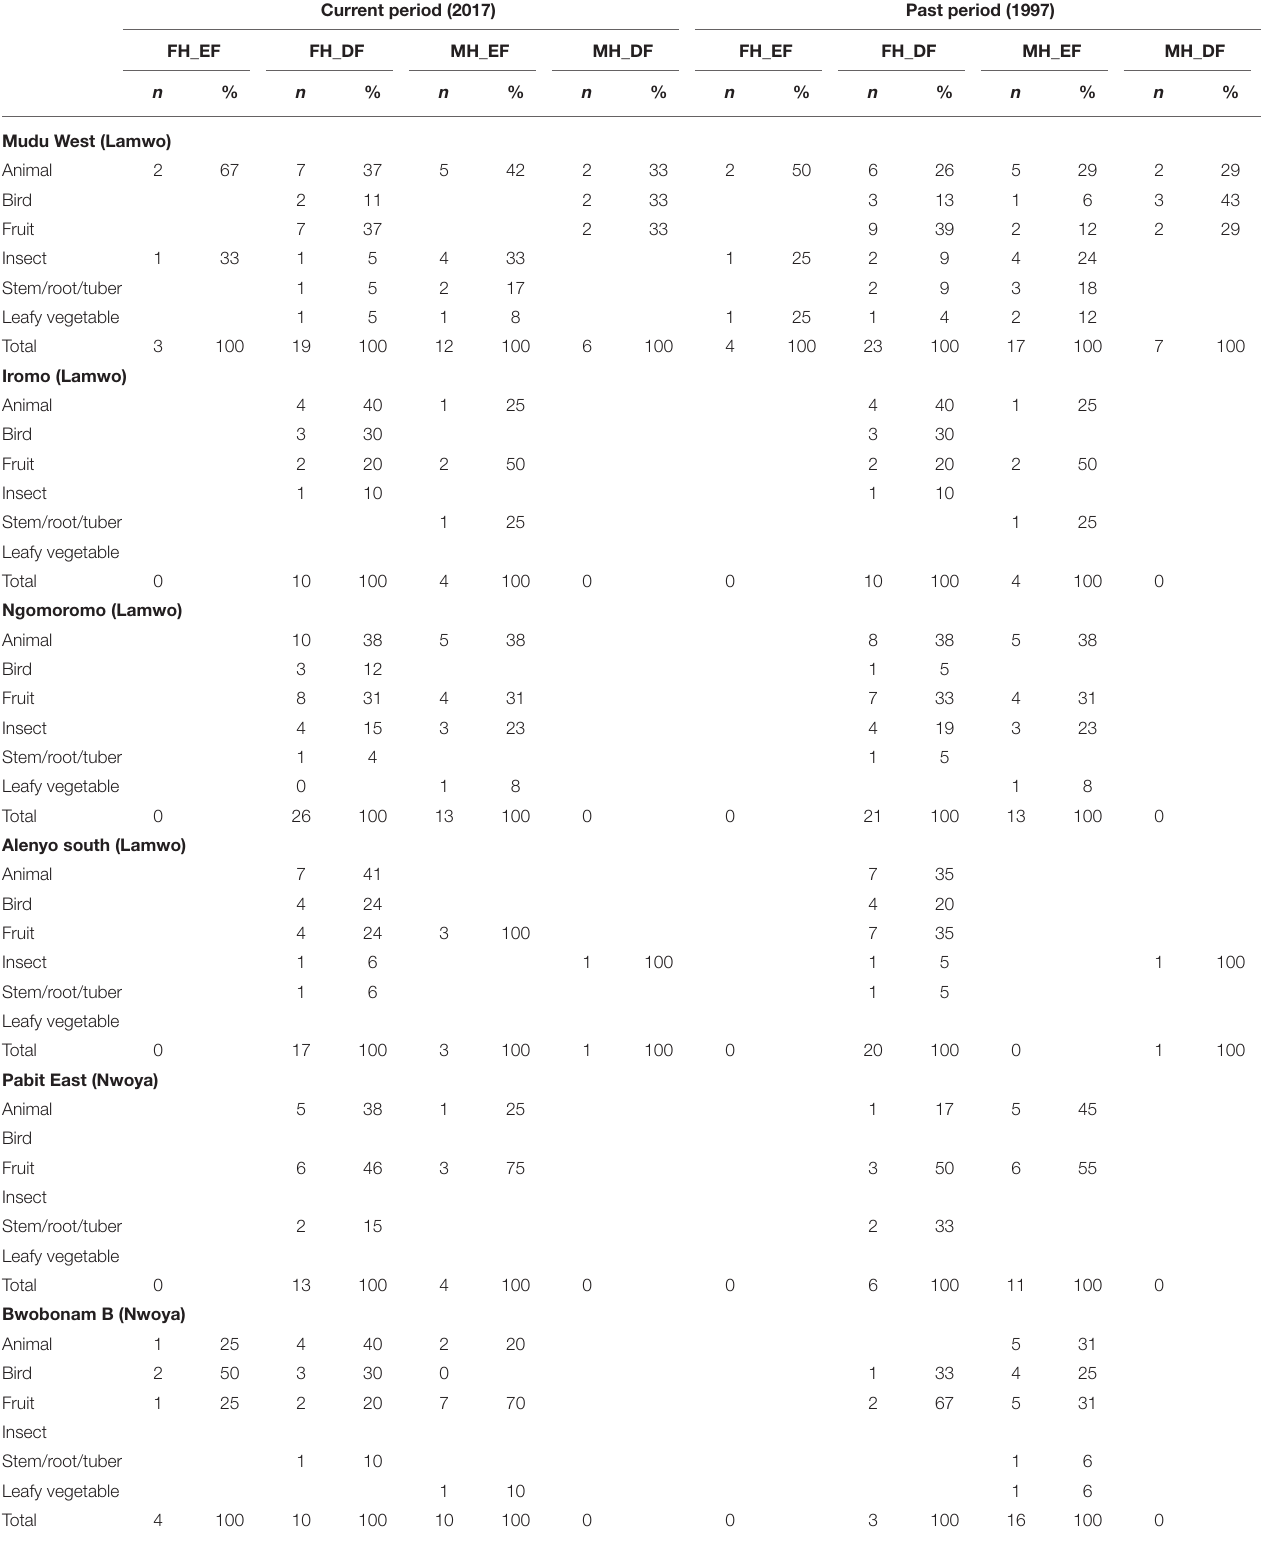
TABLE 4 | Availability species according to the 4-cell placement for the current and past period for Acholi sub-region according to village. Current period